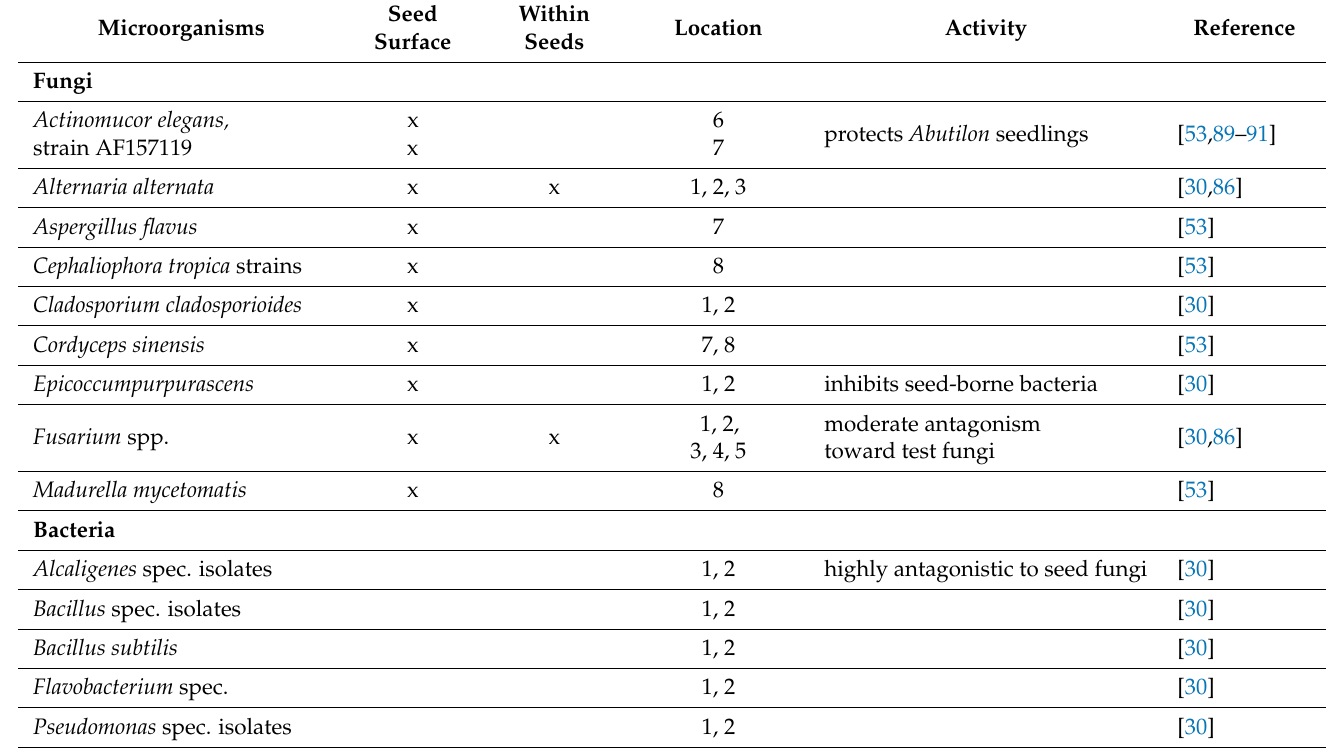
Table 2. Microorganisms known to be associated with velvetleaf. Locations: 1 Missouri